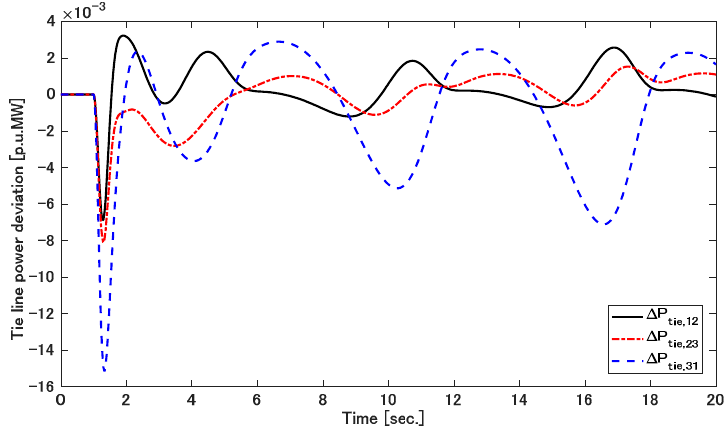
Figure 14. Tie-line power deviation of three-area power system without a wind plant.